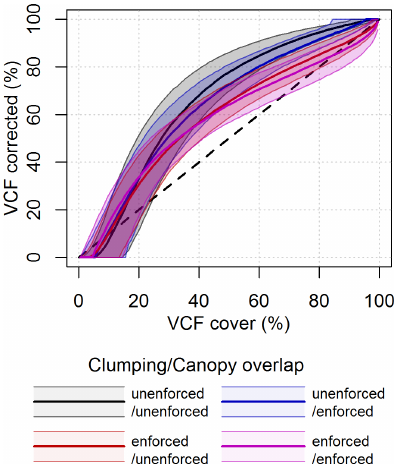
Figure A1. The calibration curves developed for MODIS VCF based on four pixel–site mismatch scenarios (no clumping and no overlap, enforced clumping and no overlap, no clumping and enforced overlap, and enforced clumping and enforced overlap). The dashed line signifies the “ideal” 1:1 relationship wherein calibrated MODIS VCF is unchanged from the original MODIS VCF values. The shaded regions represent the 5% to 95% confidence intervals for the respective calibrated MODIS VCF values.